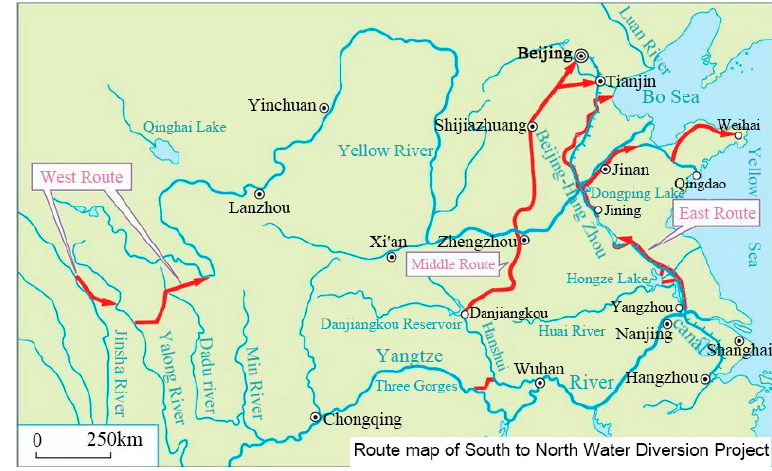
Figure 8. Route map of the South-to-North Water Diversion Project.